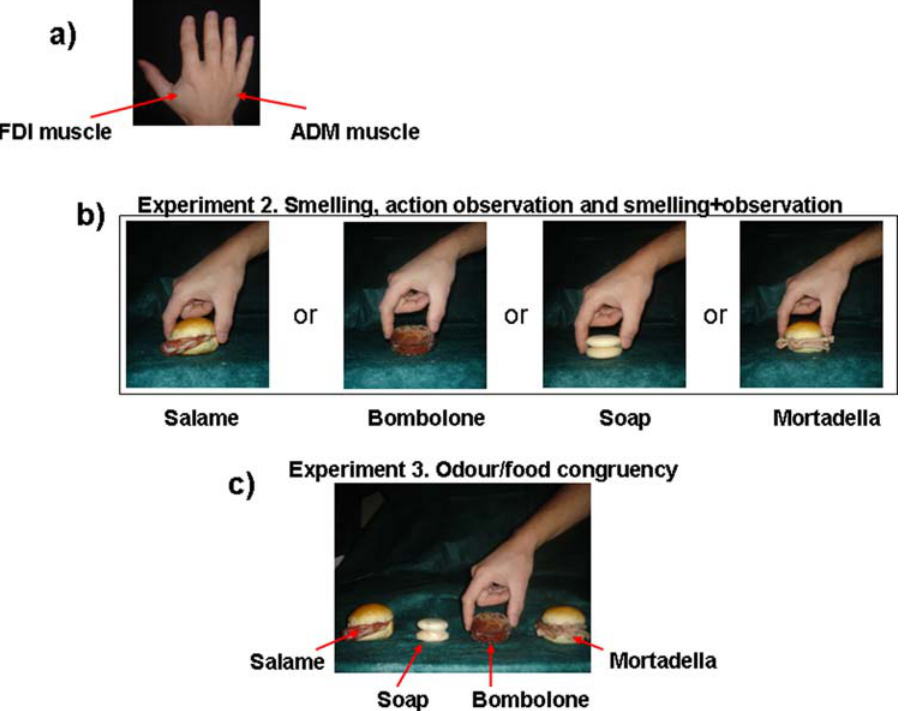
Figure 1. Experimental designs. Panel a): The two hand muscle from which motor evoked potentials (MEPs) were recorded. Panel b): Experiment 2. Here, the four food or non-food objects were separately presented. Within each of these main conditions, subjects were asked to observe the grasping (with or without the corresponding odour) or to simply smell the object without observing food or soap. ‘‘Salame’’ is the Italian name of salami, ‘‘Mortadella’’ represents the English term ‘‘balony’’, and ‘‘Bombolone’’ is the Italian word to define something like a custard filled donut. Panel c): Experiment 3. Here, the four objects were simultaneously presented. The subjects smelled a single odorant (i.e., bombolone ), while observing the experimenter reaching and grasping three edible objects (one of which was bombolone ) or a non-edible object of a similar shape